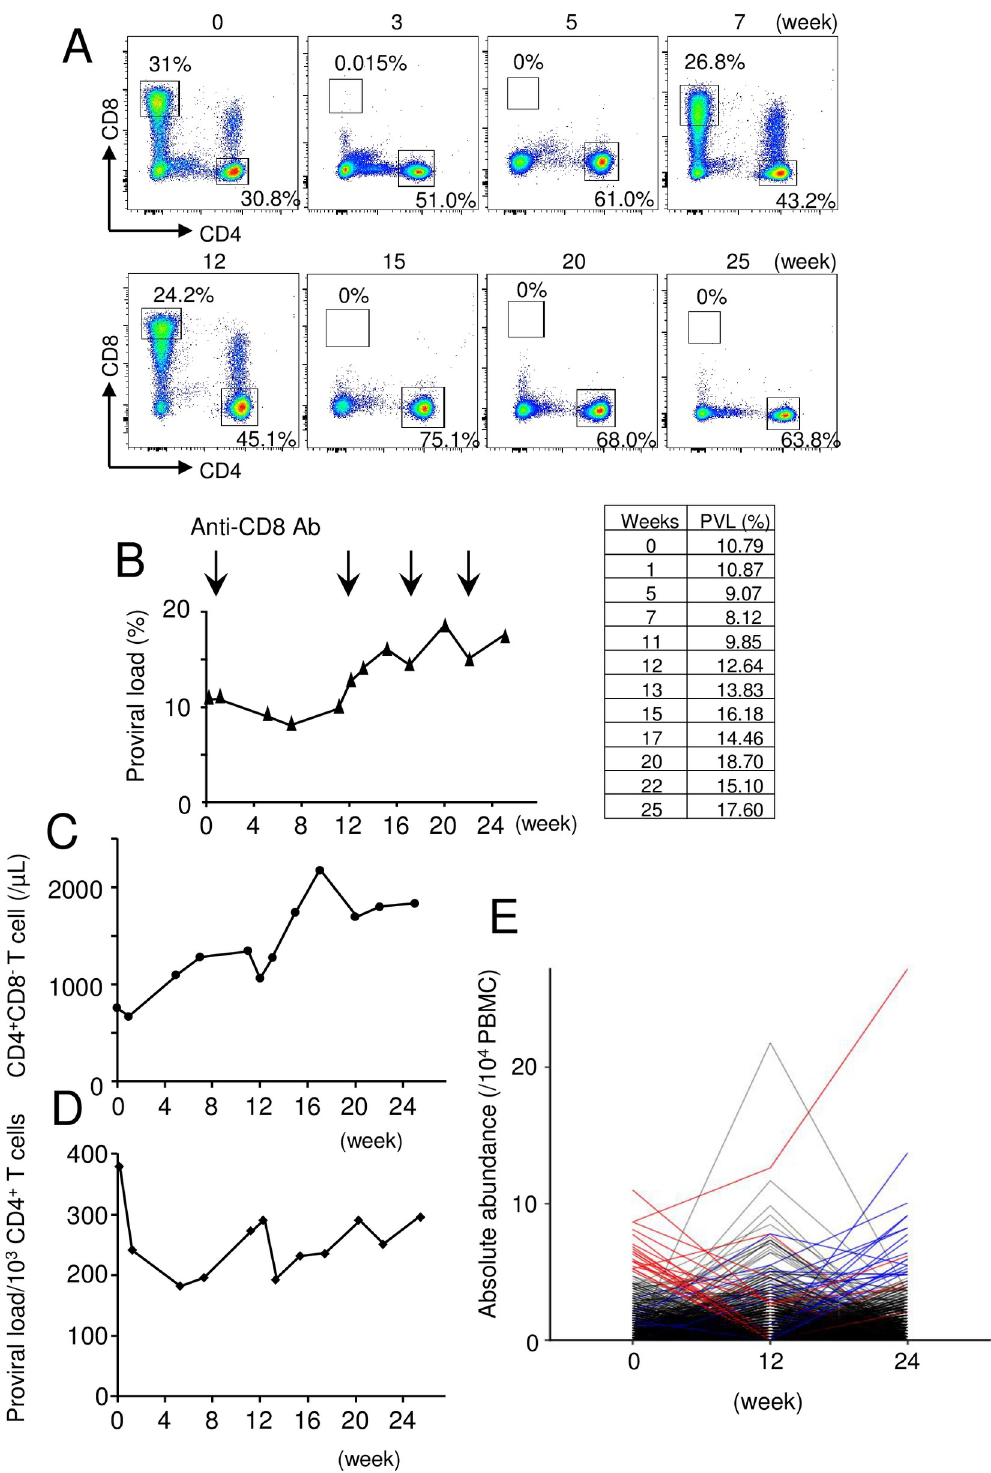
Fig 3. Effects of anti-CD8 antibody to proviral load and clonality in a STLV-1 infected Japanese macaque. Anti-CD8 antibody was administered into an STLV-1 infected Japanese macaque. (A) Percentages of CD4 + and CD8 + T cells were analyzed for PBMCs from the infected Japanese macaque before and after administration of anti-CD8 antibody. (B) Proviral load of PBMCs is shown. The time of administration of antibody is indicated by the arrows. (C) The number of CD4 + T cells